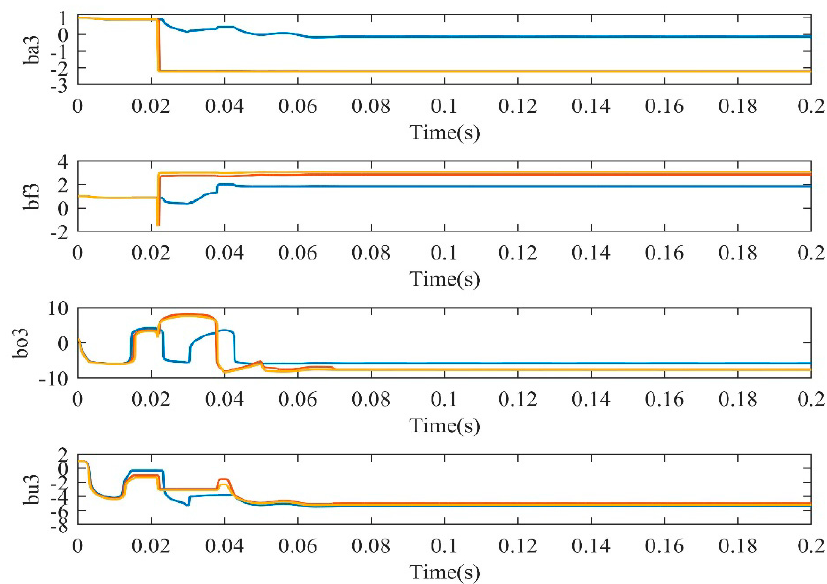
Figure 10. The second group of weights of adaptive learning curves.